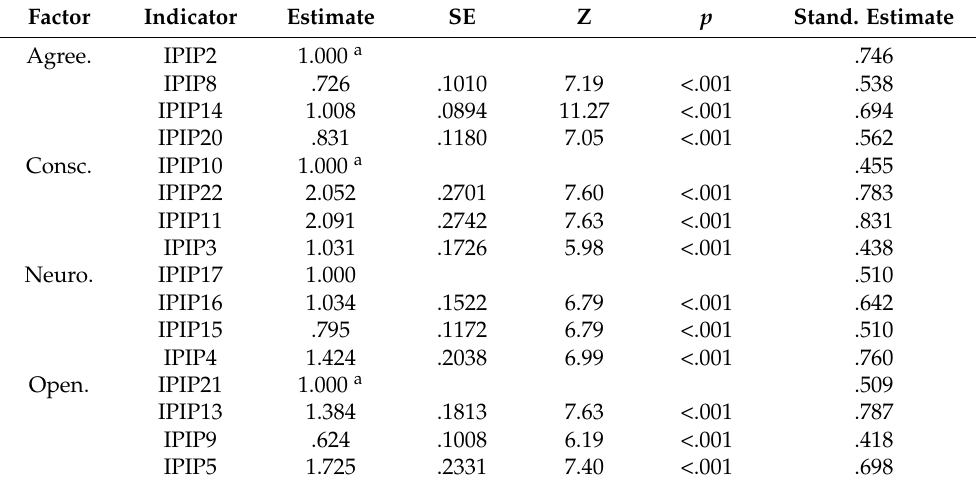
Table A1. Factor loadings of CFA (Mensa